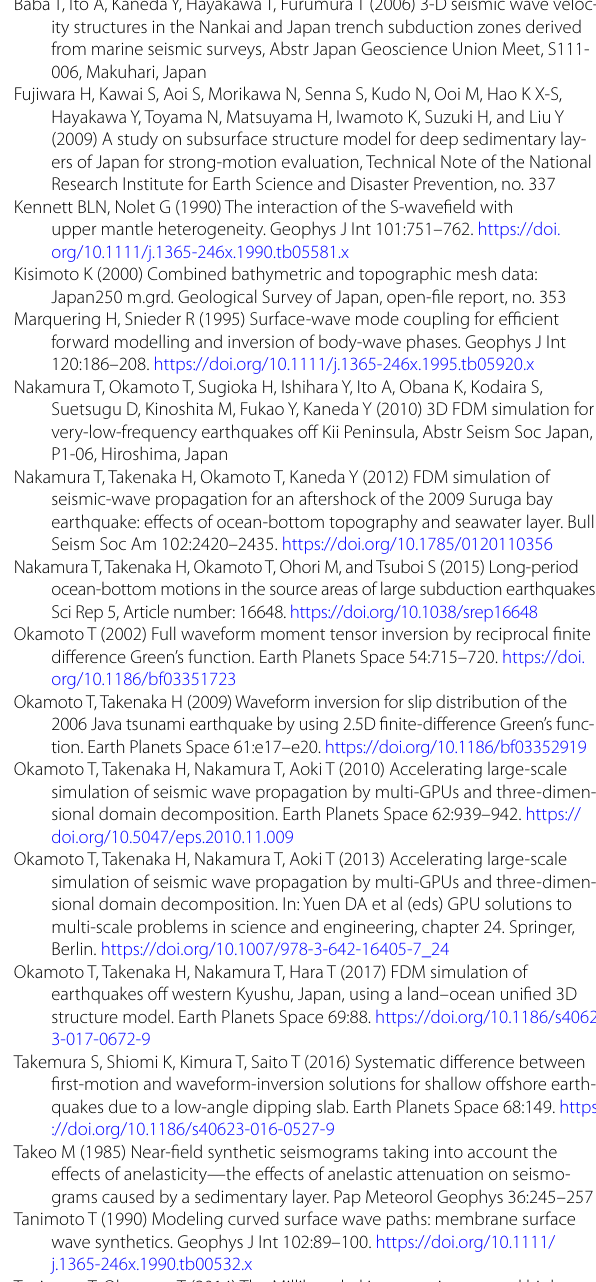
FAMT solutions. Figure S1. Residuals versus origin-time correction. Figure S2. Horizontal source locations estimated by the FAMT and other analyses. Figure S3. Comparisons of the observed and synthetic velocity wave- forms for EV2003. Figure S4. Comparisons of the observed and synthetic